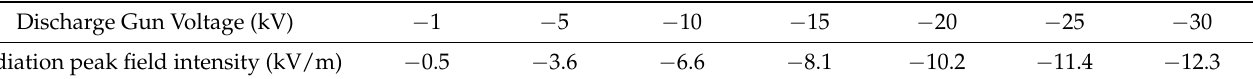
Figure 4. Pulse electric field test system. Table 1. Peak value of ESD field produced by different discharge gun voltages.